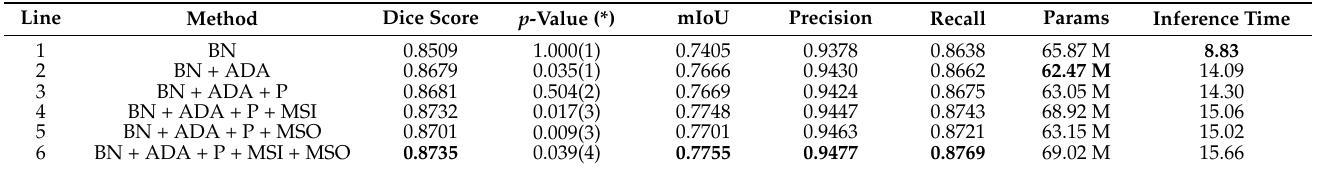
Table 2. Evaluation results of ablation experiments on the BraTS2018 dataset using six evaluation metrics. “BN” was the base network, namely, UNet; “ADA” was the axial-deformable attention module; “P” was positional embeddings; “MSI” was multi-scale input, and “MSO” was multi- scale output. The “+” of “BN + ADA” indicated that some convolution operations in the “BN” were replaced with “ADA,” and other plus signs indicated that the corresponding component was directly added to the original model. The “*” of “ p -Value (*)” denoted the line of the model used for comparison, for example, “0.035(1)” in line 2 meant we performed Wilcoxon signed-rank test between “BN” in line 1 and “BN + ADA” in line 2. The best performance was shown in